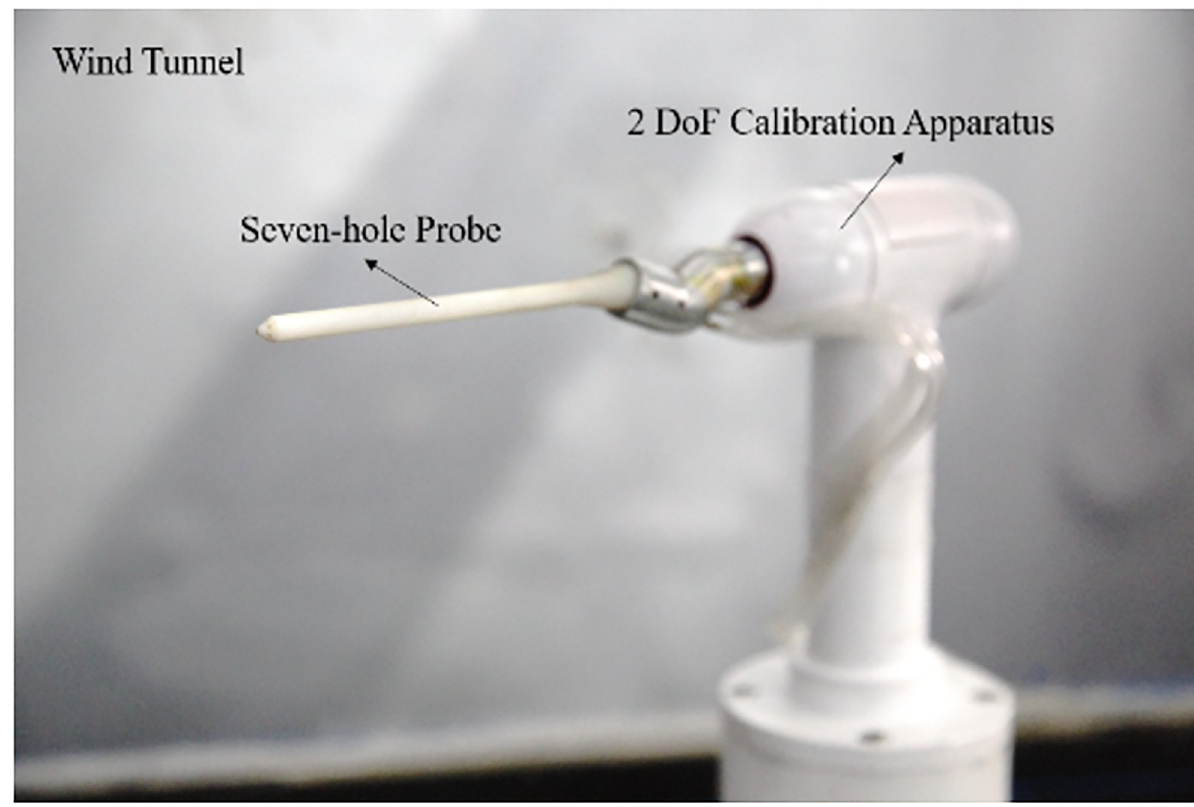
Fig 1. The experimental setup on the seven-hole probe